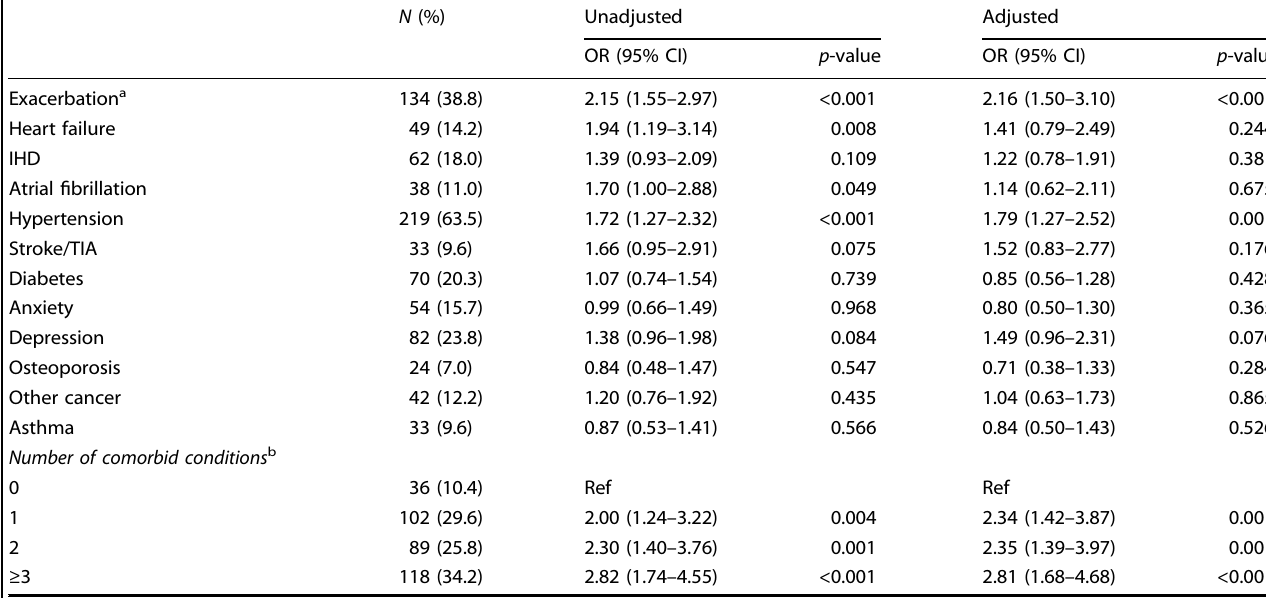
Table 3. Factors associated with having check-ups by a general